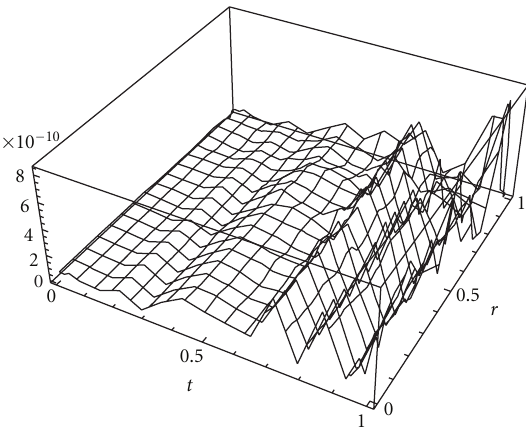
Figure 16: Absolute error of Y 15 ( t , r ) for (cid:2) = − 0 . 97265.